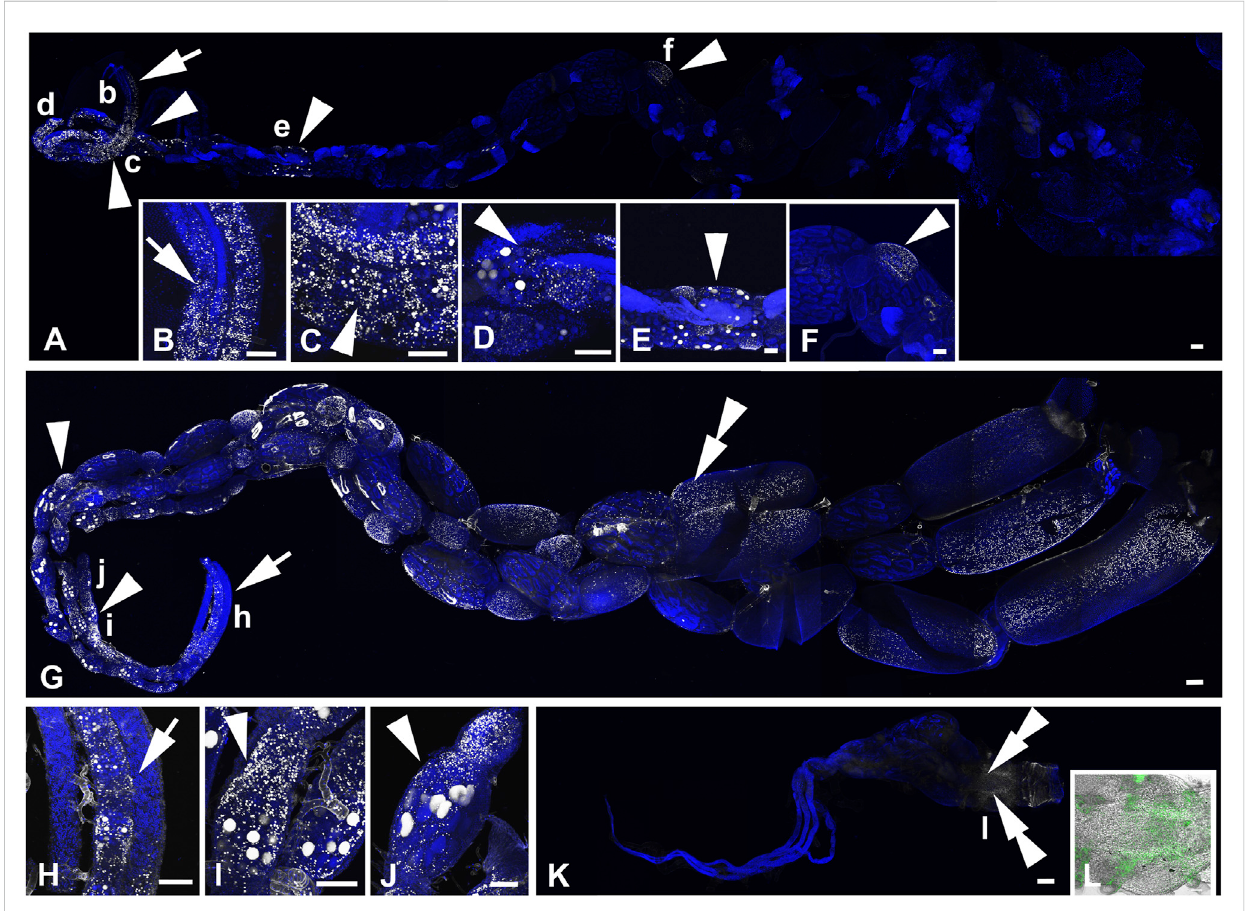
FIGURE 3 Active DNA synthesis in the ovaries of B. terrestris workers within the 12 h period. (A – F) The ovary of a representative of ovipositing workers. EdU labelling in the germarium and vitellarium of an egg-laying worker ovary (A) , the details of the EdU signal in the germarium (B) , close-up view of EdU signals in some trophocytes and follicle cells in the proximal part of the vitellarium (C – D) , EdU-signal detection of mitotically active trophocytes and follicle cells in egg chambers of the middle part (E) and the distal part (F) of the vitellarium. (G – L) The ovary of a representative of 1- to 3-week-old workers. The3Dreconstructionofthewholeovary (G) .Detailedviewofno-EdU-positivegermariumoftwoovarioles andthevitellarium ofanovarywith EdU signals in both nurse and follicle cells (H) , details of the EdU signal in some trophocytes and follicle cells of egg chambers (I – J) . Topography of a worker with small ovaries with the only EdU signal in some cells in the peritoneal sheath at the distal part of the ovary (K) . Details of EdU-positive cells in the peritoneal sheath observed using 3D fl uorescence and light confocal images (L) . The white (A – K) and green colors (L) indicate localization of EdU incorporated in active DNA synthesis in the nuclei, and the blue color shows DNA labelled by DAPI. The arrows, arrowheads, and double arrowheads in topography of the whole ovaries show EdU signals detected in the follicle and nurse cells of the germarium, the vitellarium, and cells of the peritoneal sheath, respectively. Small letters in the ovary overviews indicate the locations from which the corresponding high-magni fi cation images were taken. Scale bars in (A,G,K) 200 µm and in (B – F,H – J,L) 100